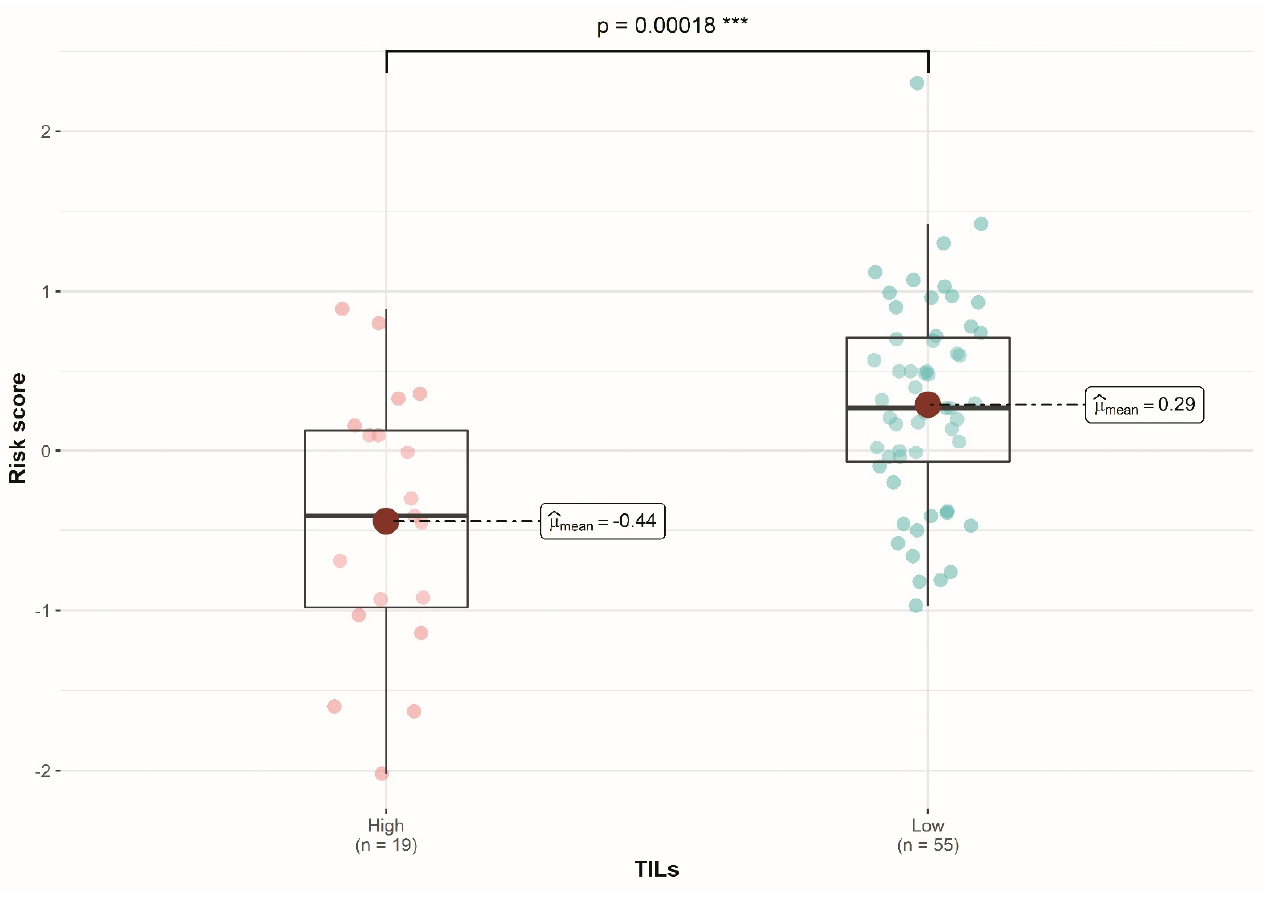
Figure 5. Comparison of the Three genes risk score according to TILs group. Patients with low TILs had a higher score. Asterisks represent statistical significance level (*** p < 0.001).